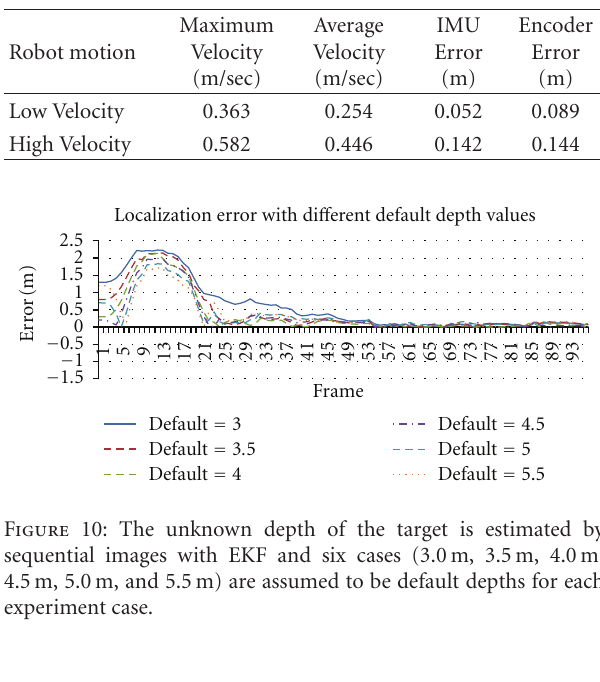
Table 2: Comparison of localization errors between the encoder and IMU.